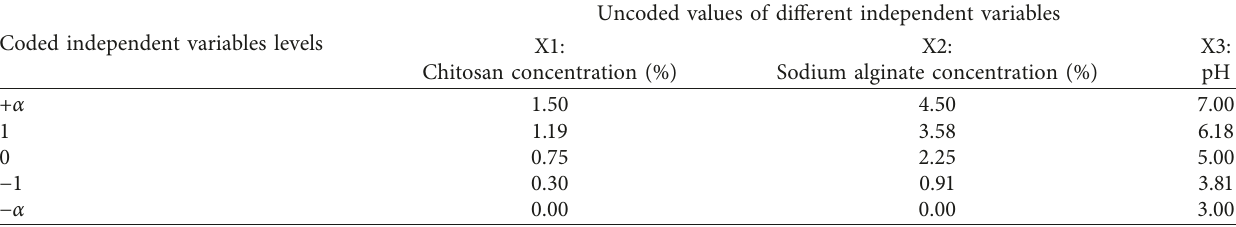
Table 1: Uncoded and coded levels of three independent variable of chitosan concentration, sodium alginate concentration, and pH used in the RSM design.